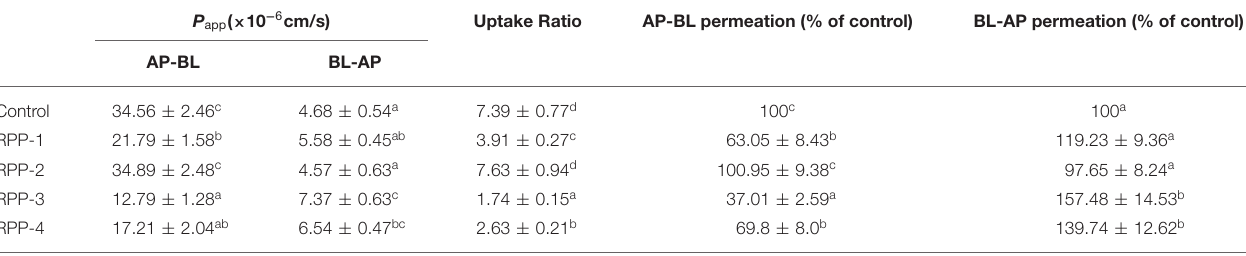
TABLE 2 | Effect of pumpkin polysaccharide RPPs on the transport of glucose across Caco-2 cell monolayer. P app ( × 10 − 6 cm/s) Uptake Ratio AP-BL permeation (% of control)